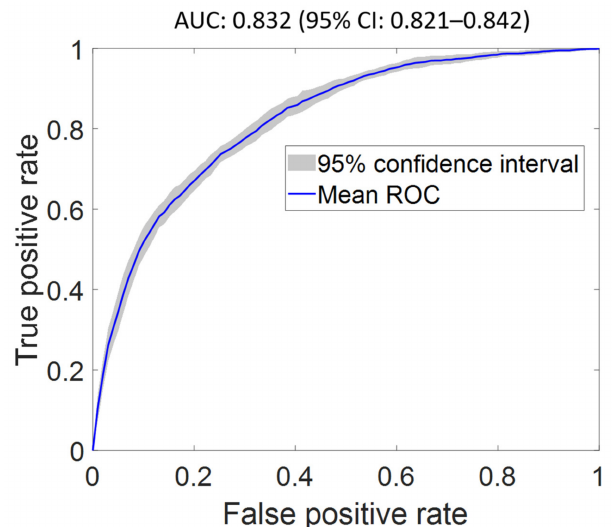
Figure 3. Optimal receiver operating characteristic curve of ST-segment elevation myocardial infarc- tion (STEMI) classifier using the optimal feature set (FS2) as input. The proposed model achieved an AUC of 0.832 (95% CI: 0.821–0.842), which is comparable to the AUC of the classifier using all features (FS1) as